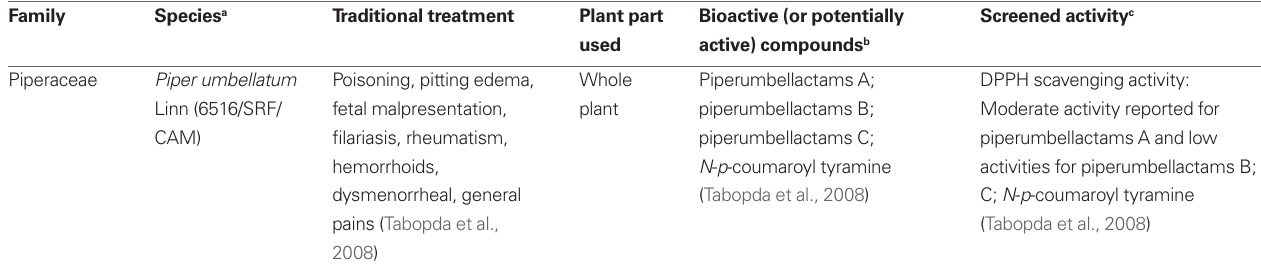
a HNC or SRFK: Cameroon National herbarium code. b Compounds characterized for the first time in Cameroonian medicinal plant are underlined. C Screened activity: DPPH or 1,1-diphenyl-2-picryl hydrazyl radical assay (evaluates the ability of antioxidants to scavenge free radicals; Hydrogen-donating ability is an index of the primary antioxidants; these antioxidants donate hydrogen to free radicals, leading to non-toxic species and therefore to inhibition of the propagation phase of lipid oxidation [Lugasi et al., 1998]); ABTS· + : 2,2-azinobis (3-ethylbenzothiazoline-6-sulfonic acid) diammonium radical cation; BHA: 3-t-butyl-4-hydroxya- nisole; Significant activity